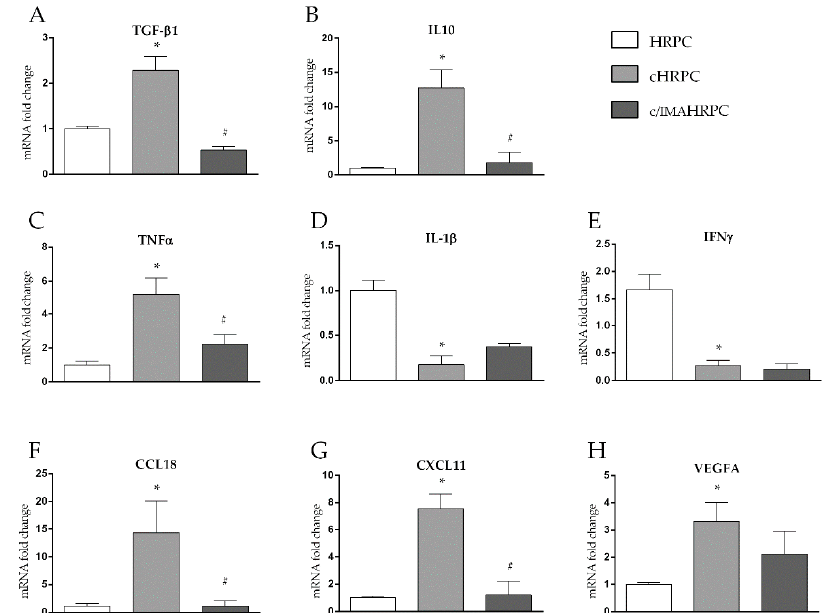
Figure 3. HRPC interacting with 92.1UM show an anti-inflammatory marker profile, an effect reduced by imatinib. Quantitative analysis of TGF- β 1 ( A ), IL10 ( B ), TNF α ( C ), IL-1 β ( D ), IFN γ ( E ), CCL18 ( F ), CXCL11 ( G ), and VEGF ( H ) mRNA levels in pericytes cultured alone (HRPC) or in the presence of 92.1UM without (cHRPC) or with 5 μ M of imatinib (c/IMAHRPC) for 6 days. Results are relative to those of basal levels in control HRPC cultured for 6 days alone and normalized to the housekeeping reference gene ribosomal 18S RNA expression. All data represent mean ± SEM obtained from three independent experiments. * p < 0.05 vs. control (HRPC); # p < 0.05 vs. coculture conditions without imatinib. One-way ANOVA, followed by Tukey’s test. Moreover, a strong increase of IL10 mRNA levels (about 11.5-fold change, p < 0.05) in cHRPC compared to control HRPC (Figure 3B) was observed. The presence of 5 μ M of imatinib in coculture completely prevented the increase of both the anti-inflammatory cytokines induced by 92.1UM as evidenced by mRNA levels of TGF- β 1 and IL10 in c/IMAHRPC similar to control HRPC. Interestingly, 6 days of coculture with 92.1UM triggered a significant increase of pro-inflammatory cytokine TNF- α mRNA of about 3.5-fold ( p < 0.05) and a reduction of IL-1 β and IFN- γ mRNA levels of about 75% and 85%, respectively ( p < 0.05, Figure 3C–E). HRPC cocultured with 92.1UM in the presence of imatinib (5 μ M) showed restored levels of mRNA only for TNF- α , whereas they remained unchanged for IL-1 β and IFN- γ in comparison to cHRPC. Overall, these data indicate a modulation of inflammation genes in favor of an immunomodulatory phenotype. Next, we tested the involvement of chemokines CXC11 and CCL18 as well as VEGFA as they were found involved in uveal melanoma recruitment of tumor-associated microphages and angiogenesis [54,55]. mRNA levels in HRPC after 6 days of coculture with 92.1UM in comparison to control HRPC (of about 13, 7, and 3-fold changes, respectively, p < 0.05) (Figure 3F–H). Moreover, this induction was completely reduced by the presence of 5 μ M imatinib in the coculture medium for CXCL11 and CCL18 mRNA levels and only partially for VEGFA levels (Figure 3F–H). These data suggest that